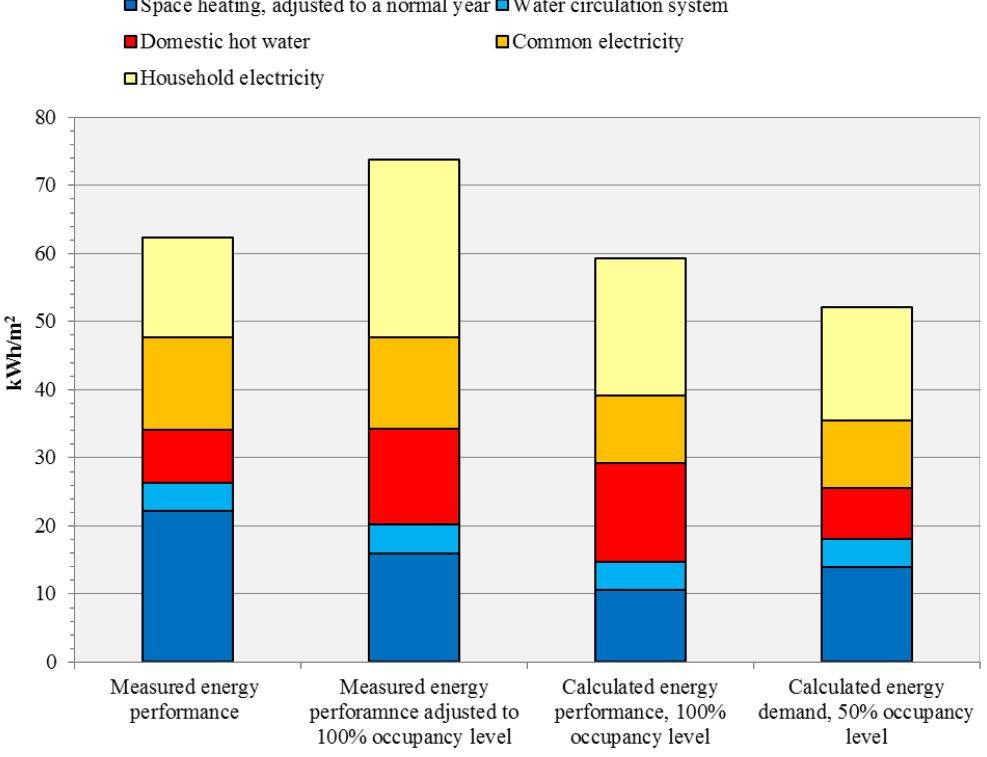
Figure 6. Total energy use. Monitored values are adjusted to 100% occupancy level and compared to simulated values for full and half occupancy. Space heating demand is adjusted to a normal